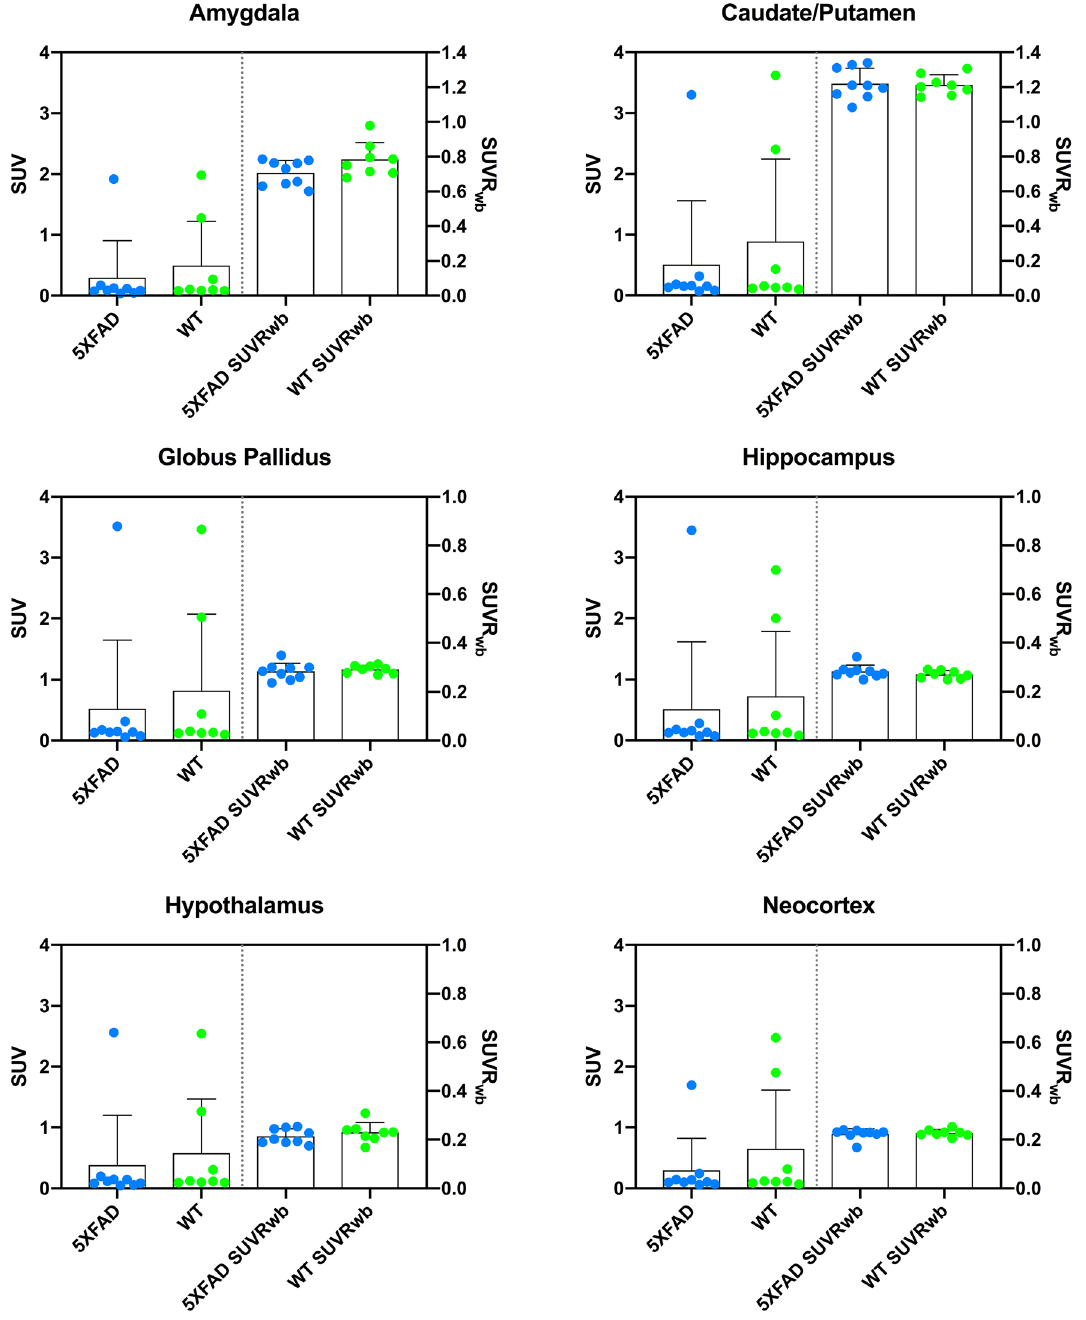
Figure 4. Regional [ 99m Tc]HMPAO SPECT perfusion measured in 5XFAD (blue) and WT (green) mice at 11.2 months of age. Standardized uptake values (SUV; left) and corresponding relative standardized uptake values with whole brain reference region (SUVR wb ; right) were evaluated in the amygdala, caudate/ putamen, globus pallidus, hippocampus, hypothalamus, and neocortex. No significant differences in regional perfusion were observed between 5XFAD and WT mice in any of the regions for either SUV or SUVR metrics (0.357 ≤ p ≤ 0.936). Individual subjects are represented by colored circles and the bar plot indicates mean ±